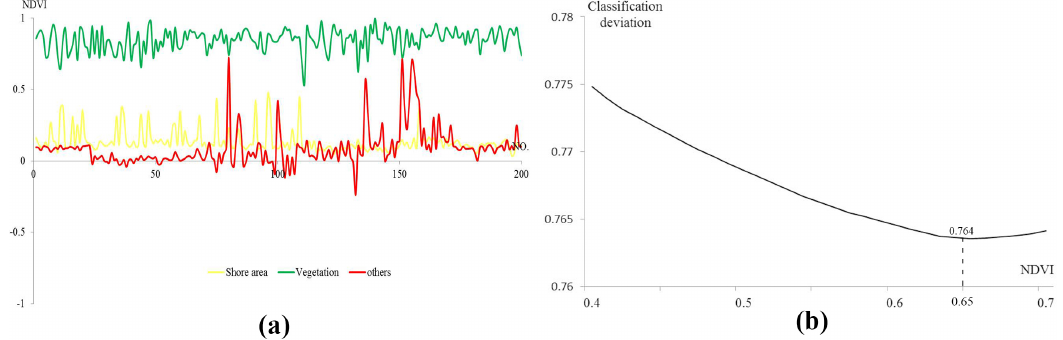
Figure 4. Determination of T v . ( a ) NDVI line of each category. ( b ) Deviation trend with the NDVI value changing from 0.4 to